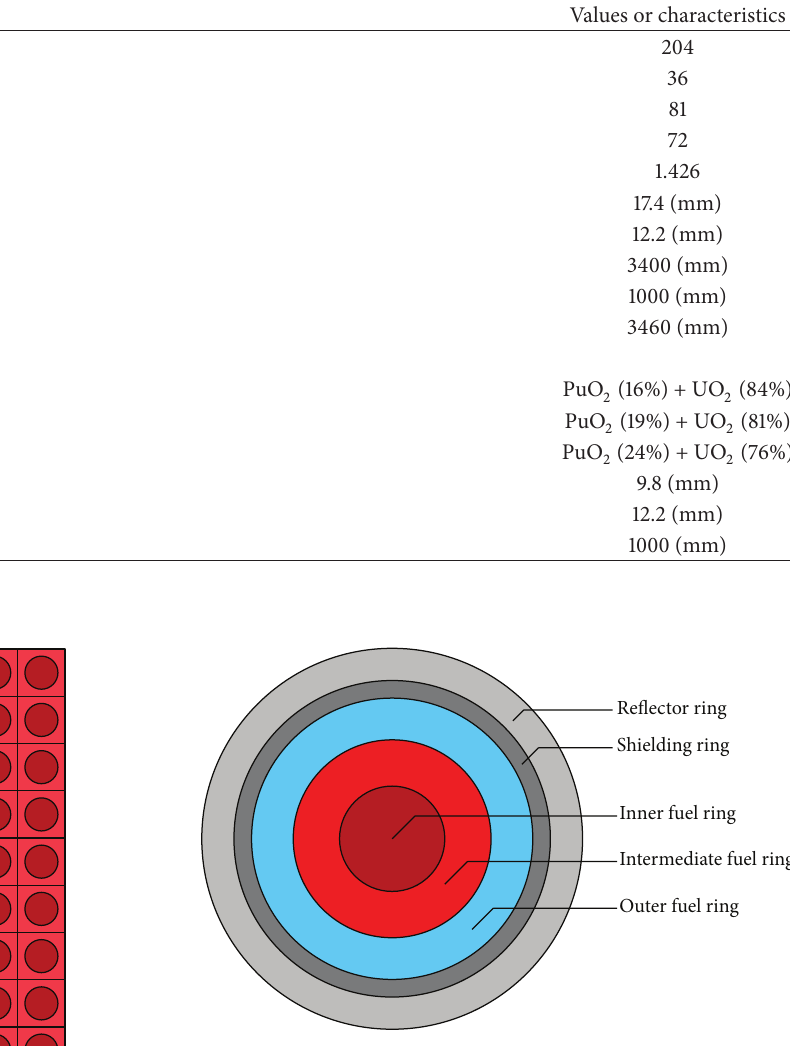
Figure 5: The simplified CFD model of SNRLFR-100